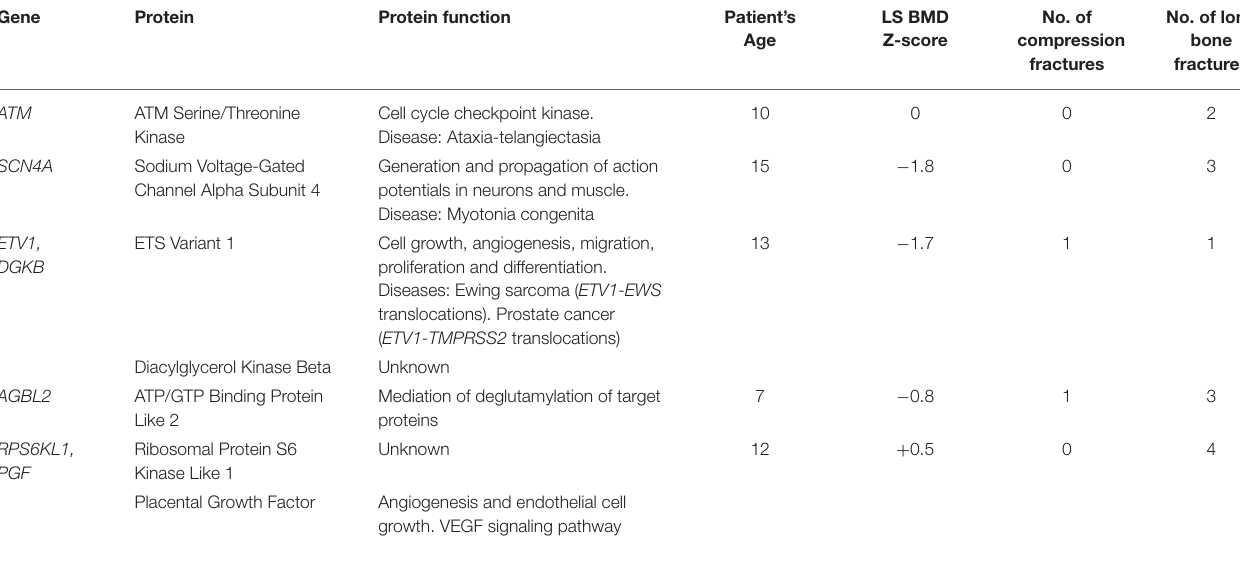
TABLE 2 | Proteins encoded by the genes involved in the 5 variants of uncertain significance and clinical information for the affected patients. Gene Protein Protein function Patient’s